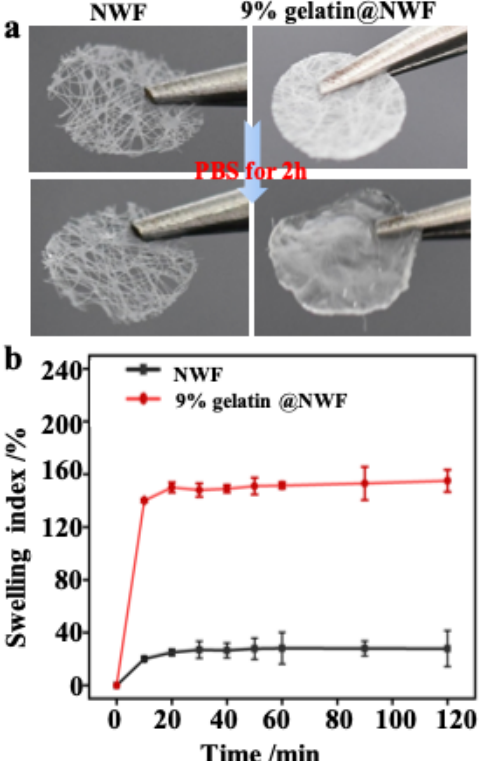
Figure 2. Swelling property of gelatin@NWF scaffold: ( a ) photographs of the scaffold before and after swelling; ( b ) swelling kinetics curve.